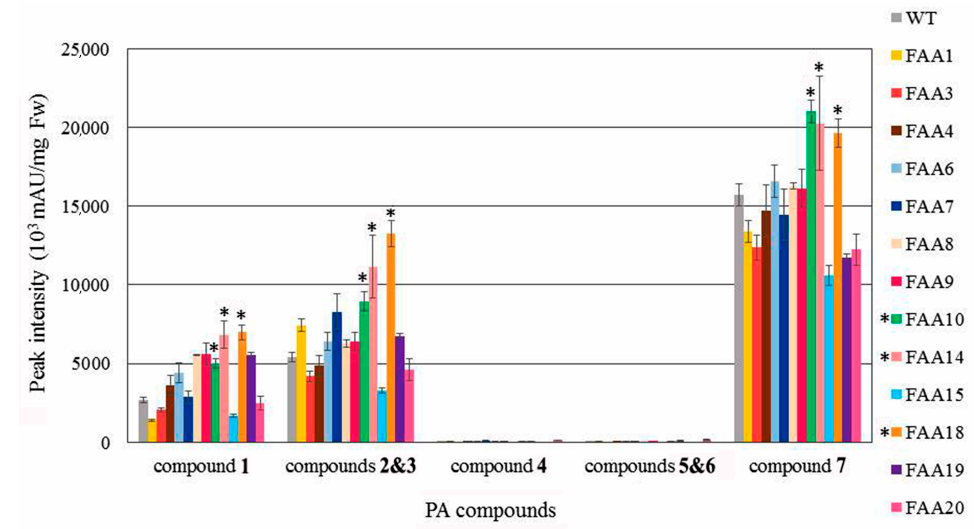
Figure 10. Metabolite profiling in leaf tissue from wild-type and FAA transformants of B. pilosa. The symbol * indicates higher content of the polyacetyenic (PA) compound as compared with WT. The name and chemical structure of each PA compound are indicated in Figure 9. The results from three or more independent experiments are presented as mean ±